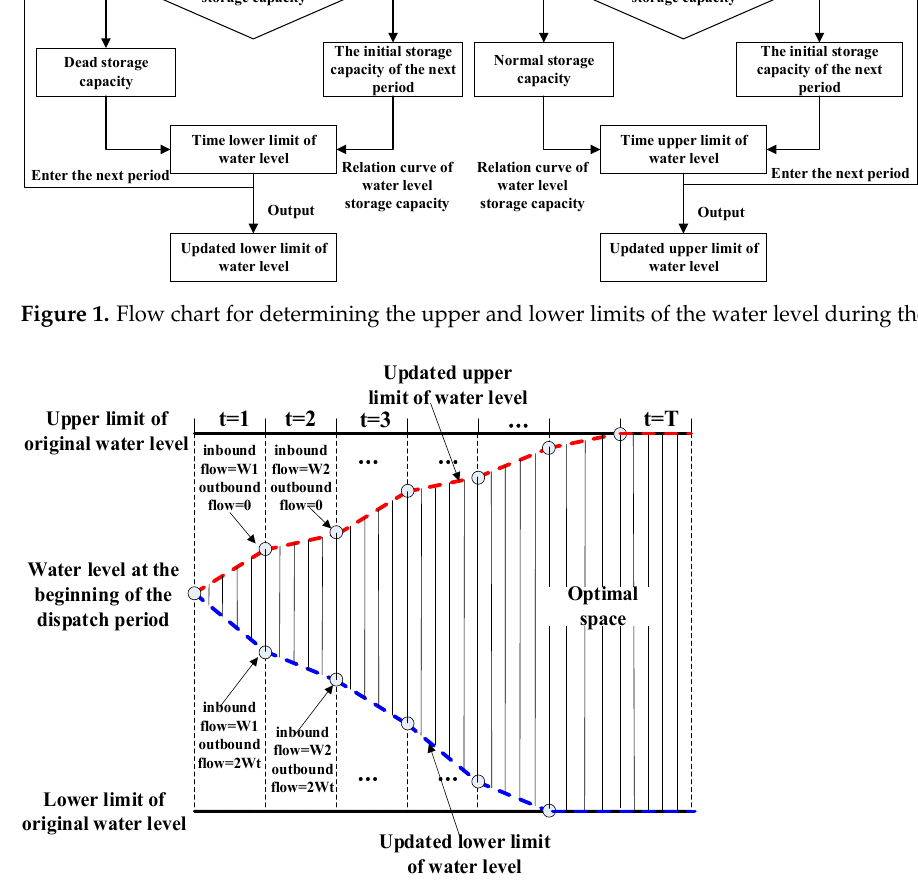
Figure 2. Schematic diagram of determining the upper and lower limits of the water level during the period.